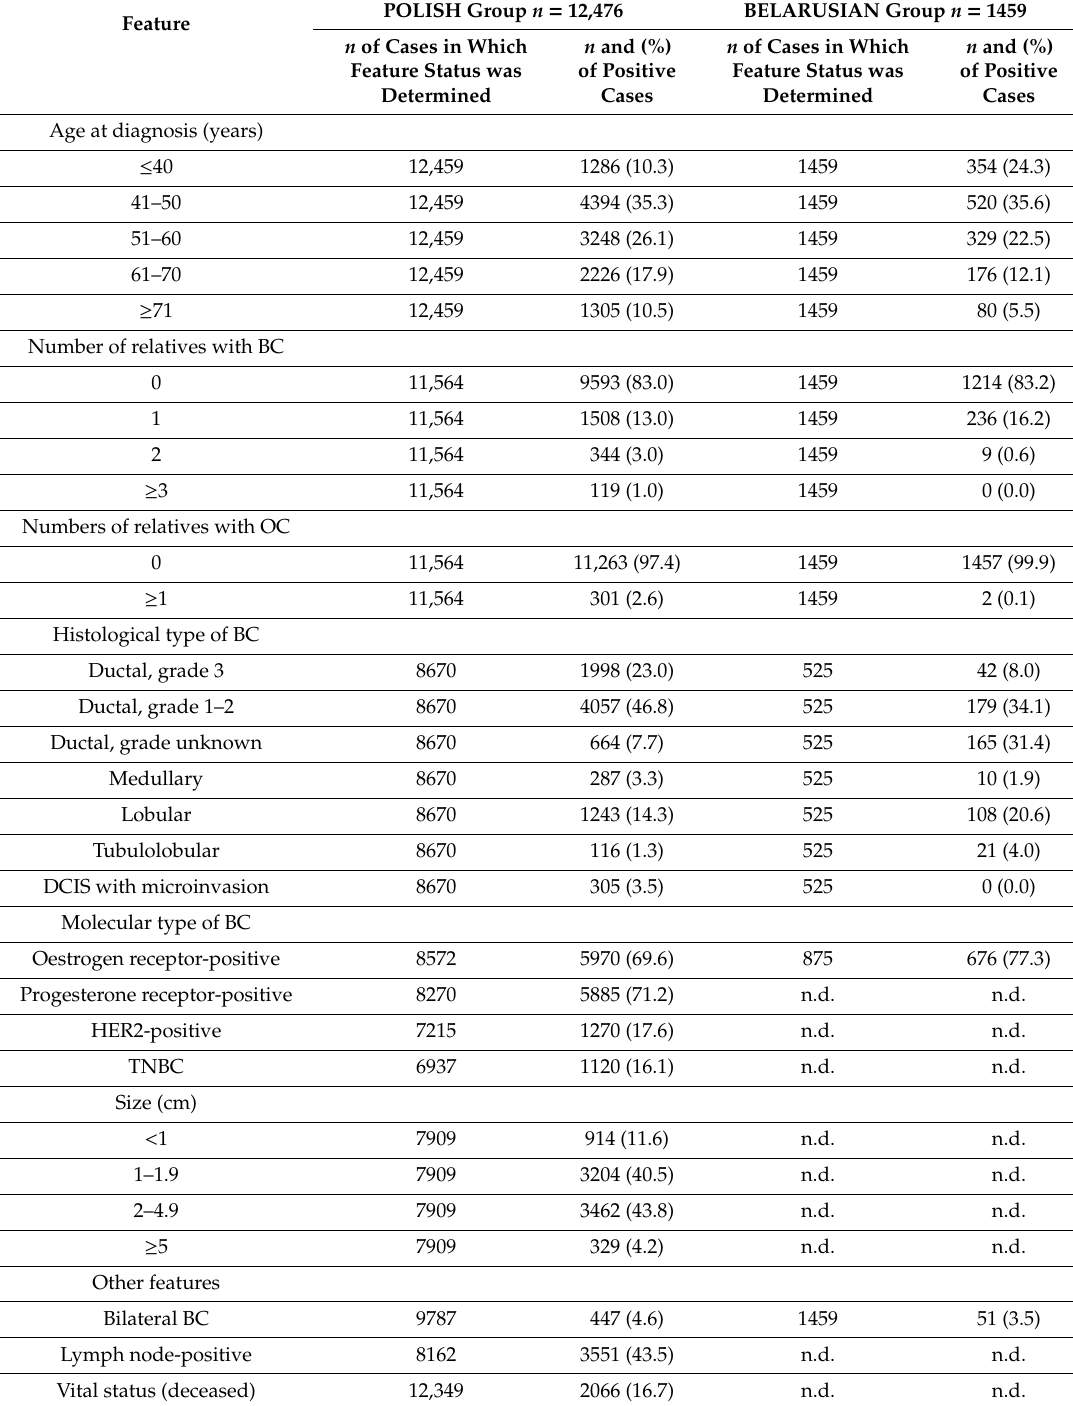
Table 4. Clinical characteristics of the BC